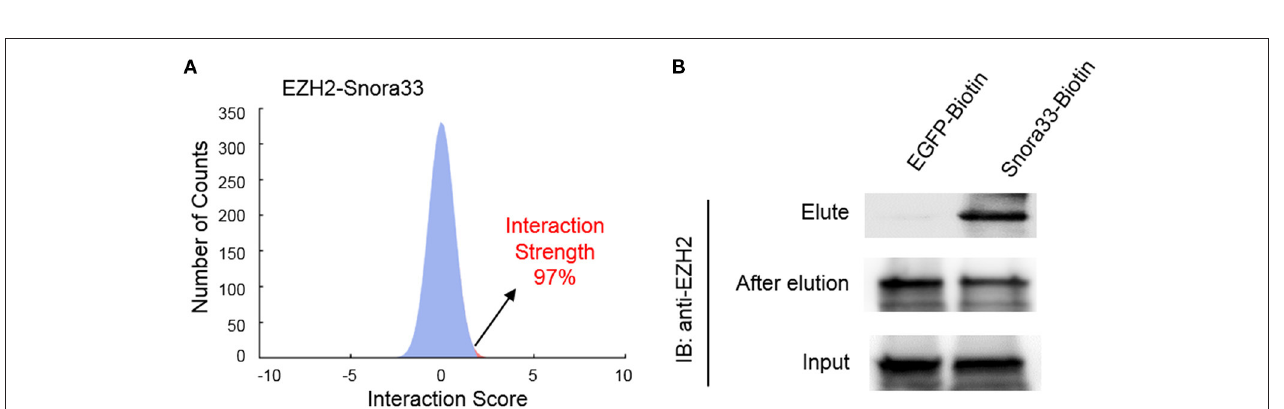
FIGURE 4 | Structural characteristics of EZH2-associated ncRNAs. Predicted secondary structure of lncRNA Gm15832 (A) , Snora family ncRNAs and Snord family ncRNAs (B) using RNAfolder.